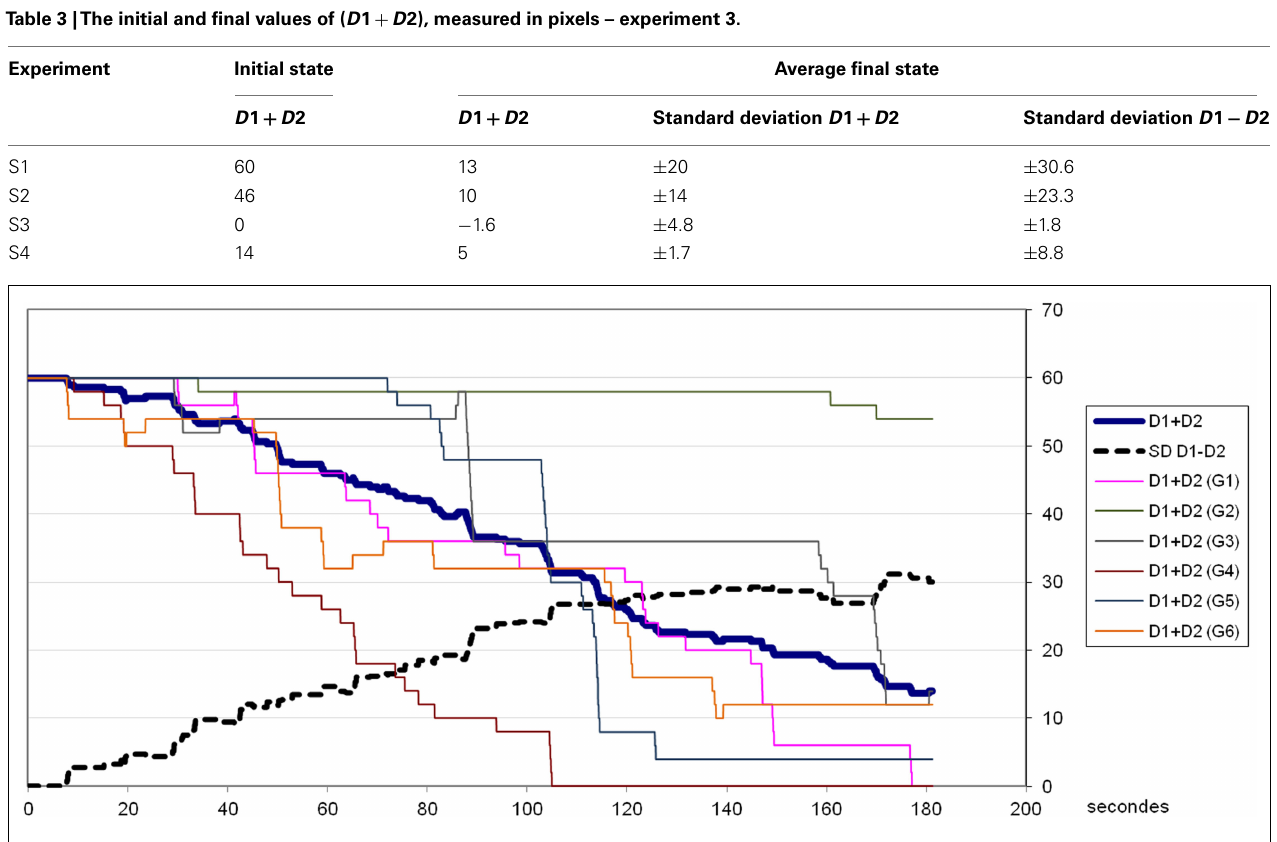
3min of the session.The thick line represents the evolution of the mean of ( D 1 + D 2).The dotted line indicates the dispersion of the values D 1 and D 2 (the standard deviation of the difference D 1 − D